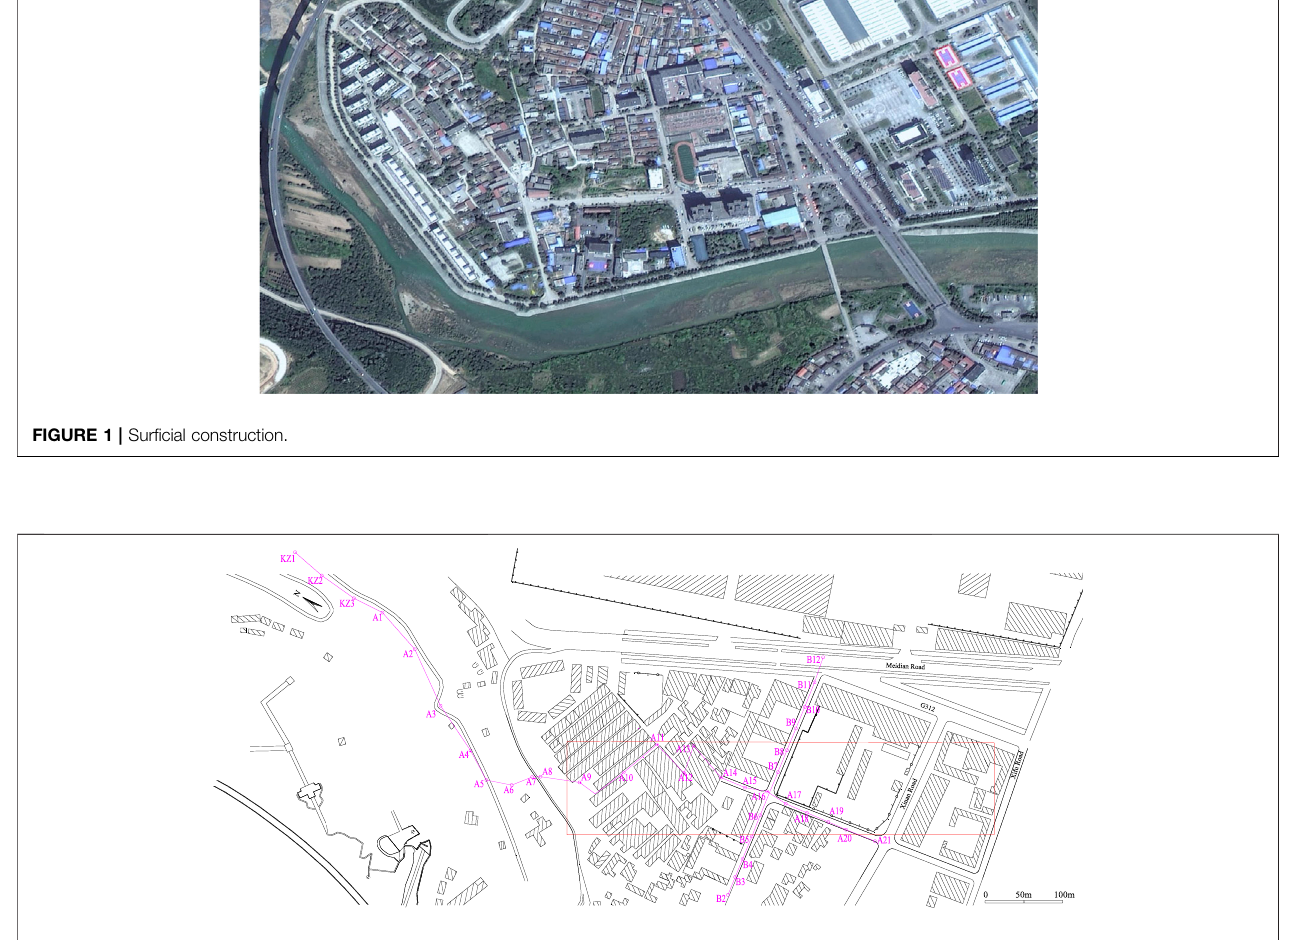
FIGURE 2 | Observation route